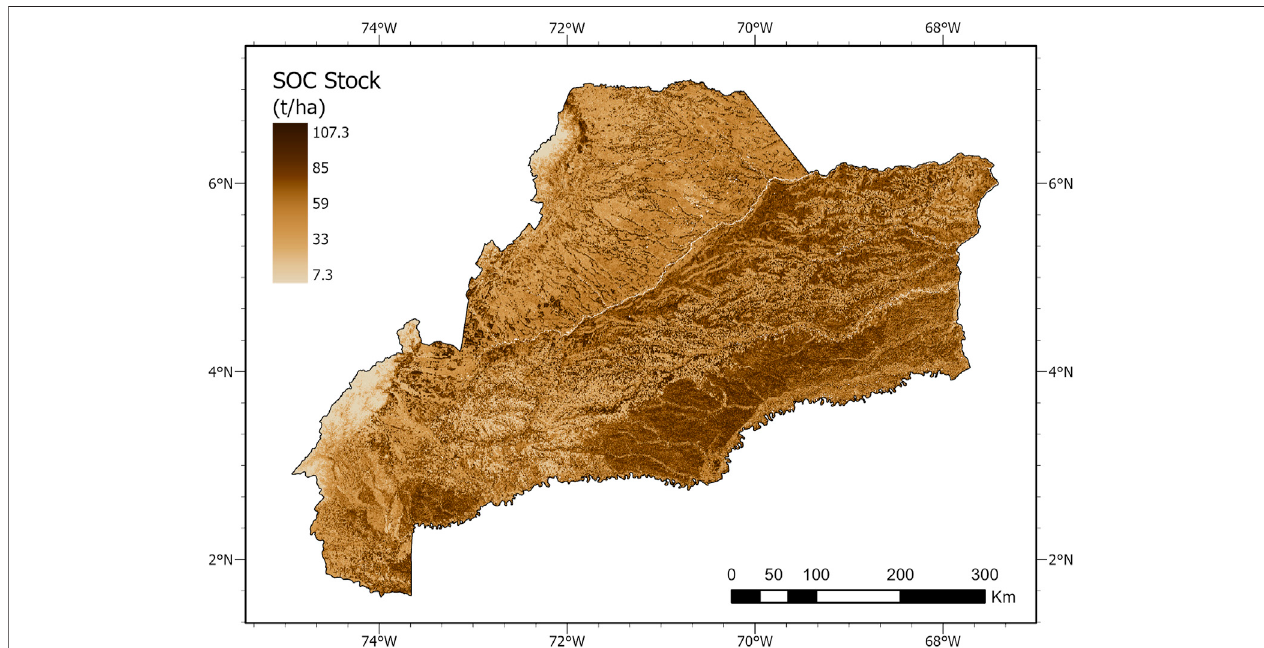
FIGURE 4 | Predicted SOC stock (t ha − 1 ) in the Eastern